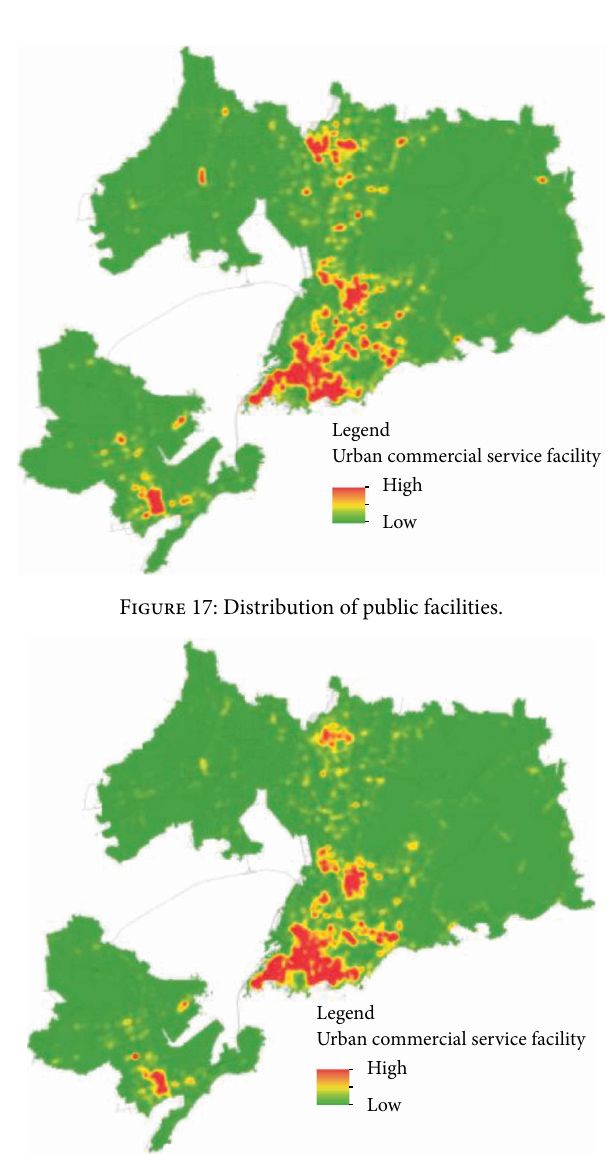
Figure 18: Distribution of commercial facilities.